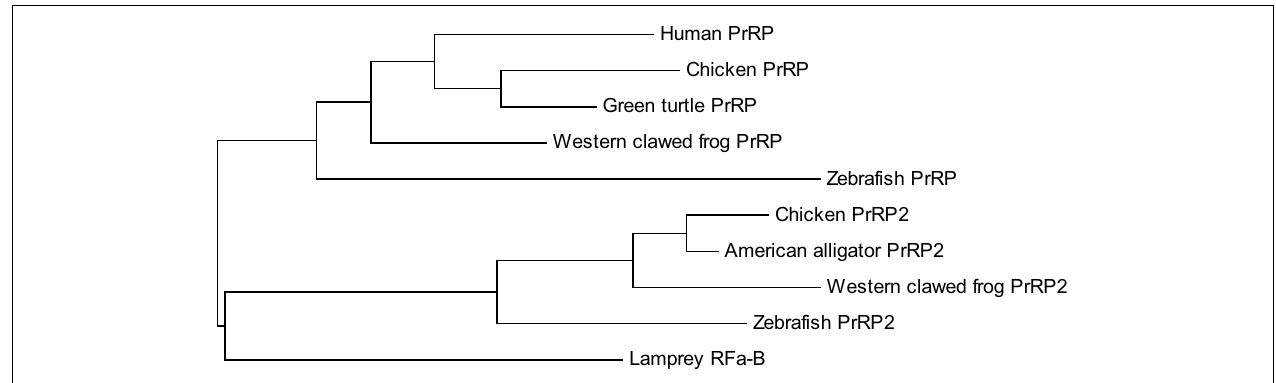
FIGURE 2 | Phylogenetic relationship between proPrRP and proPrRP2 in vertebrates .The tree was constructed using the maximum likelihood method, plotted in MEGA6.